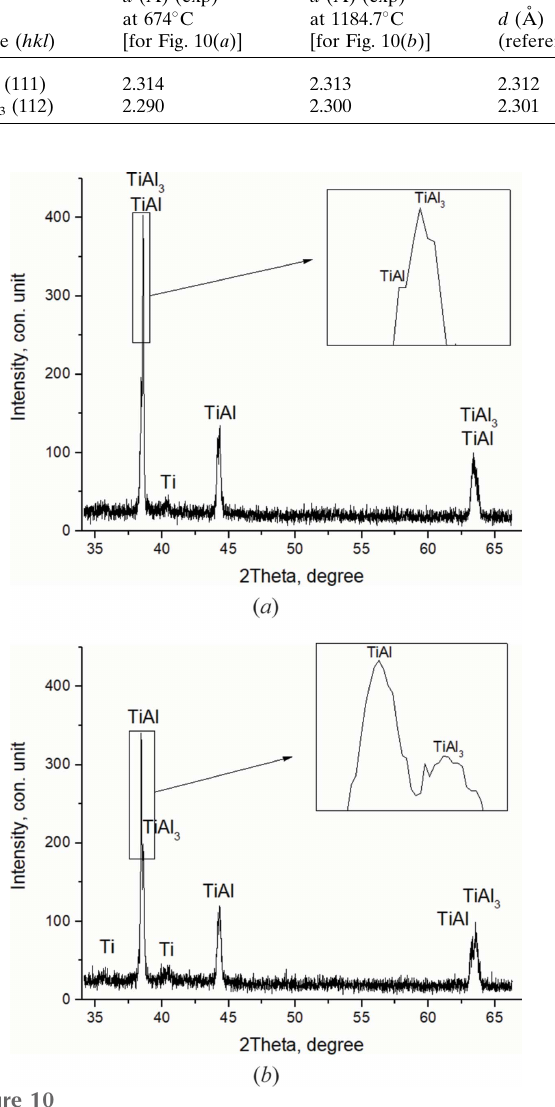
Figure 10 Diffractograms of the 29th ( T = 674 (cid:3) C) ( a ) and the 31st ( T = 1184.7 (cid:3) C) ( b )